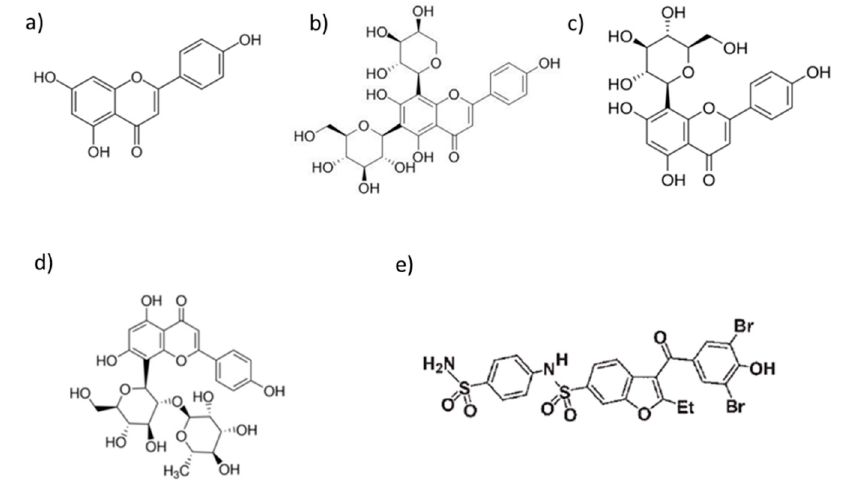
Figure 7. Chemical structures of Apigenin (API) ( a ), Schaftoside (SCH) ( b ), Vitexin (VIT) ( c ) Vitexin-2 ′ ’-O-rhamnoside (VRA) ( d ) and 3-(3,5-dibromo-4-hydroxy-benzoyl)-2-ethyl-benzofuran-6-sulfonic acid(4-sulfamoyl-phenyl)-amide (BFS) ( e ).